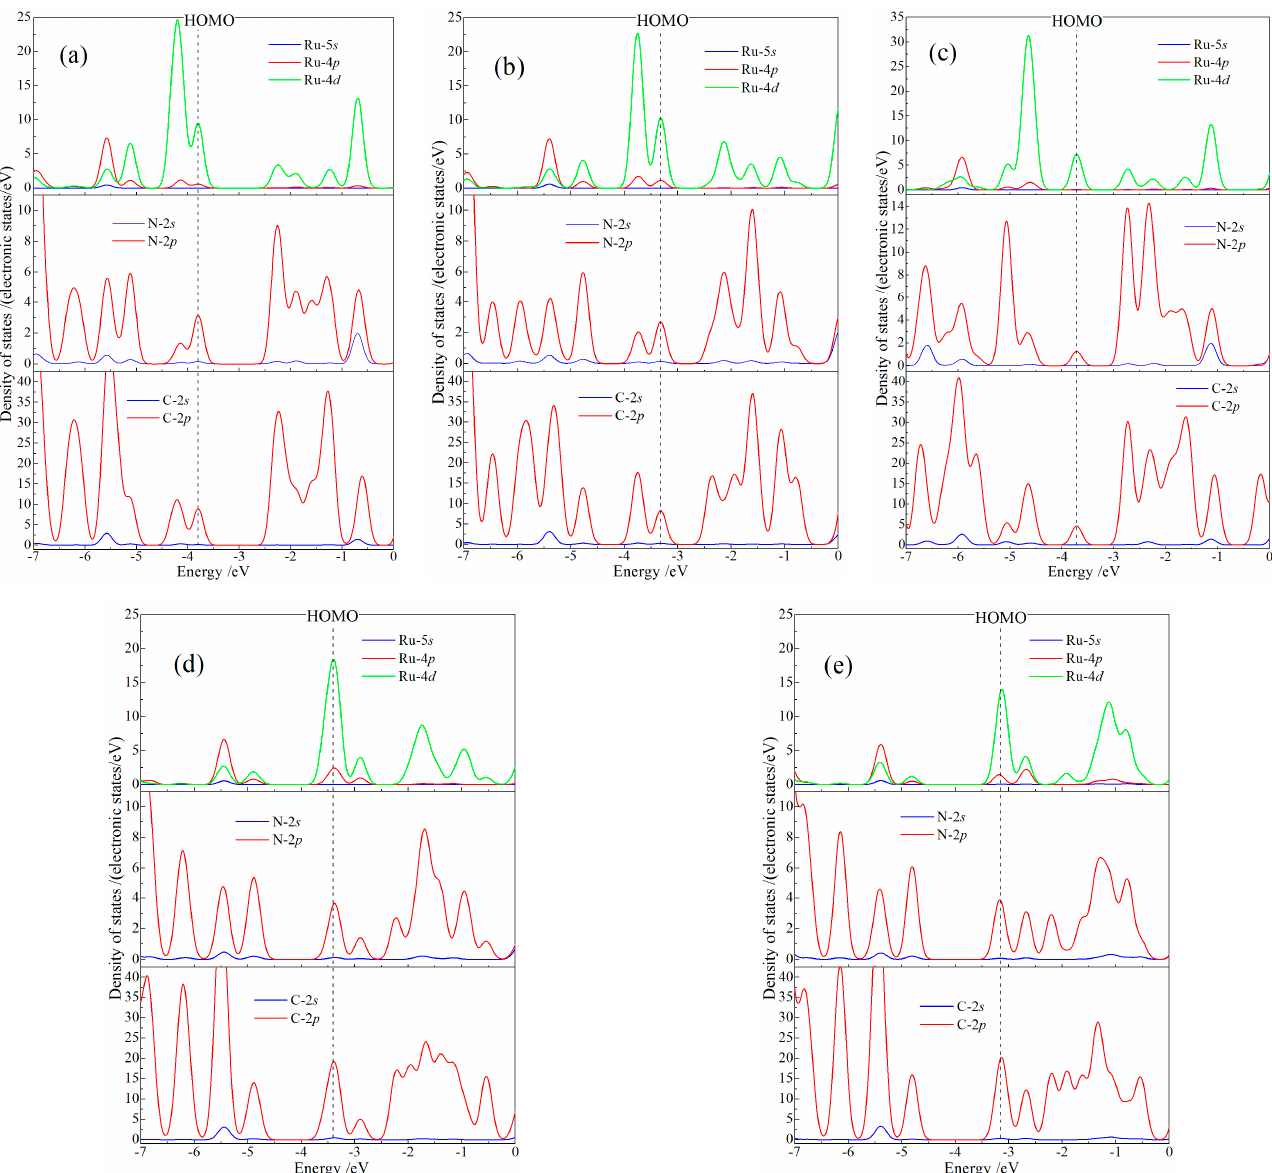
Figure 5. Total density of states and the orbital-resolved atom-projected density of states for CTTC molecule in redox states of ( a ) +2, ( b ) +3 ( c ) +4, ( d ) +5 and ( e ) +6. Vacuum free electron level is referenced as energy